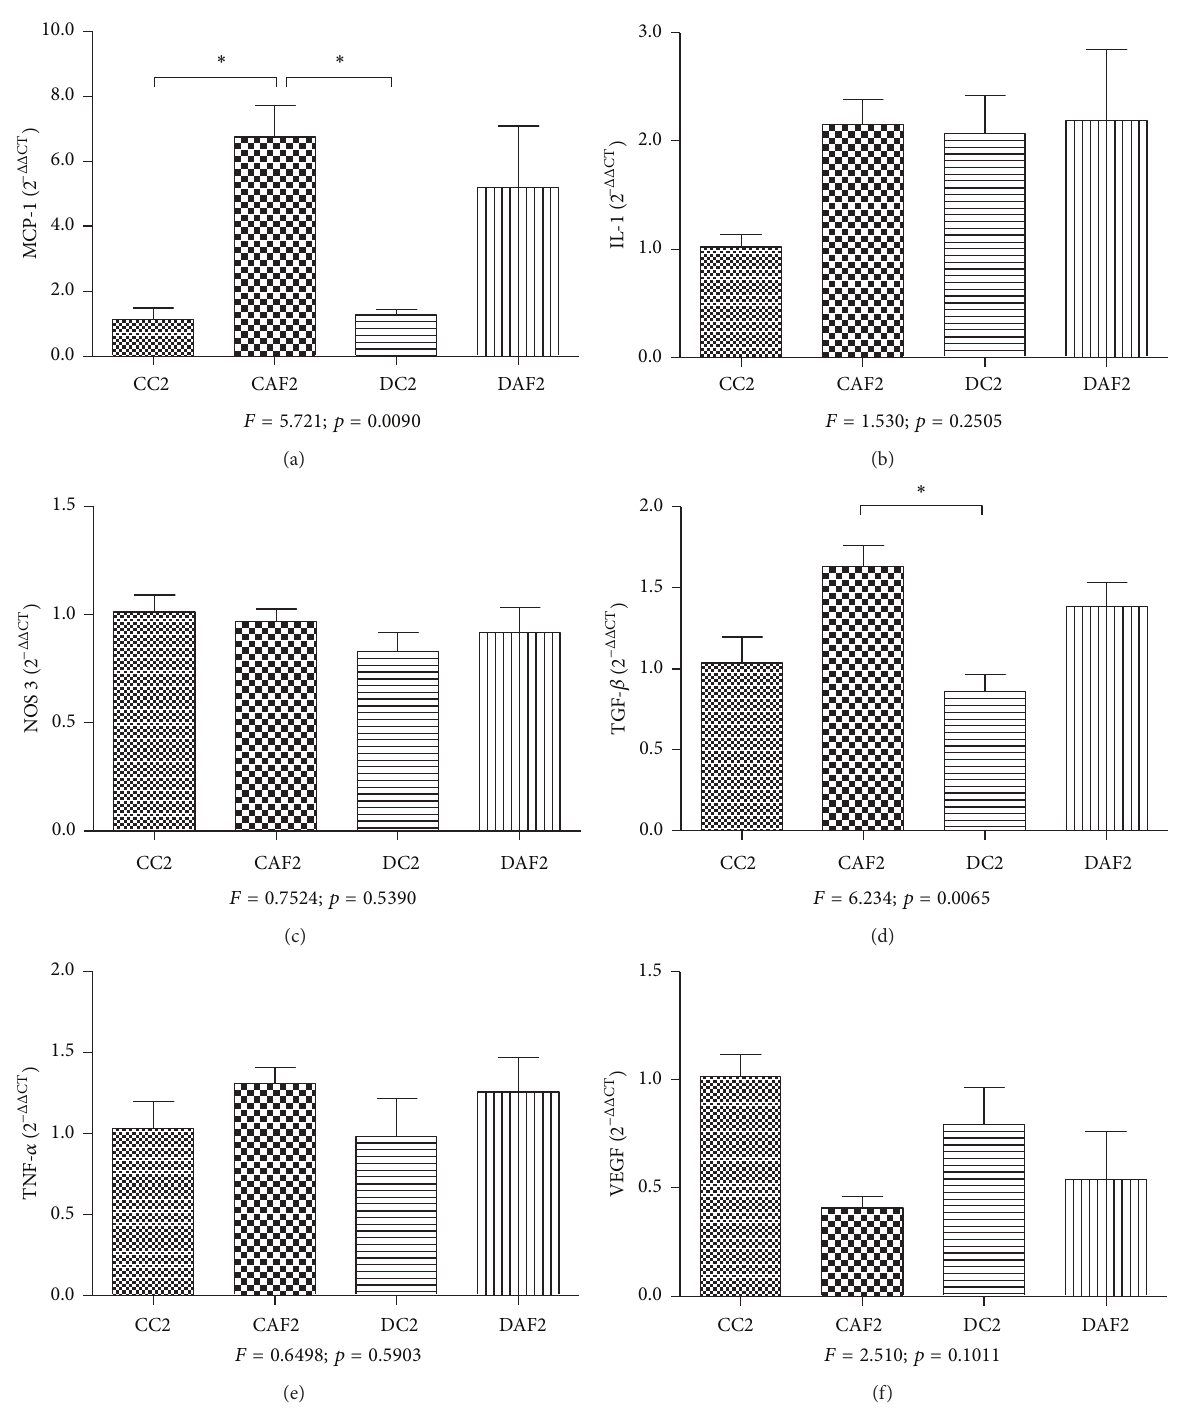
Figure 3: mRNA gene expression of MCP-1, IL-1, NOS3, TGF- 𝛽 , TNF- 𝛼 , and VEGF in the kidney of control offspring and diabetic offspring with or without folic acid, aged two months. (a) The gene expression of MCP-1 was increased in the CFA2 group; (b and c) the gene expression of IL-1 and NOS3 showed no significant difference between the study groups; (d) the gene expression of TGF- 𝛽 was decreased in the DC2 group; (e and f) the gene expression of TNF- 𝛼 and VEGF showed no significant difference between the groups. ∗ Significant